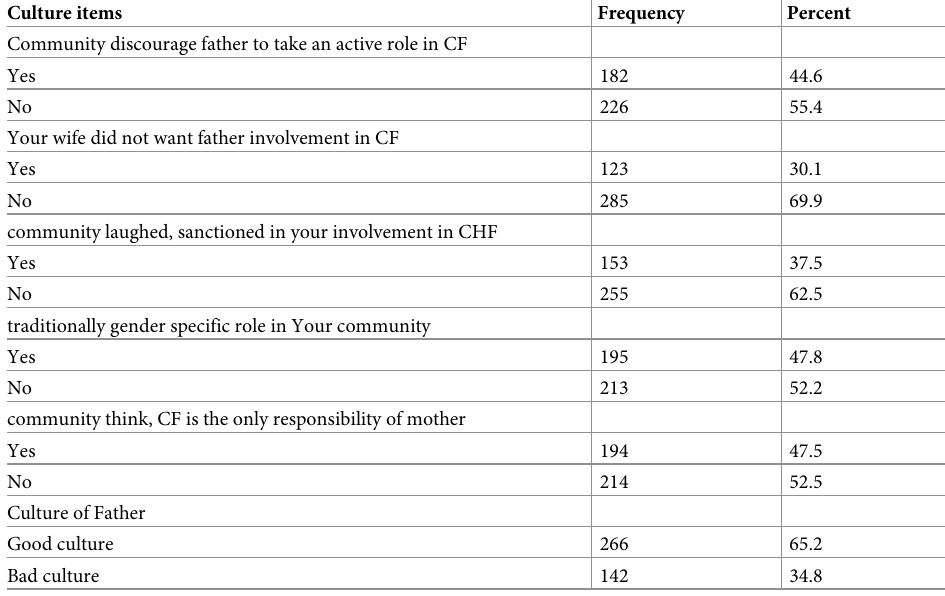
Table 4. Culture of fathers about father involvement in child feeding in Antsokia Gemza Woreda,